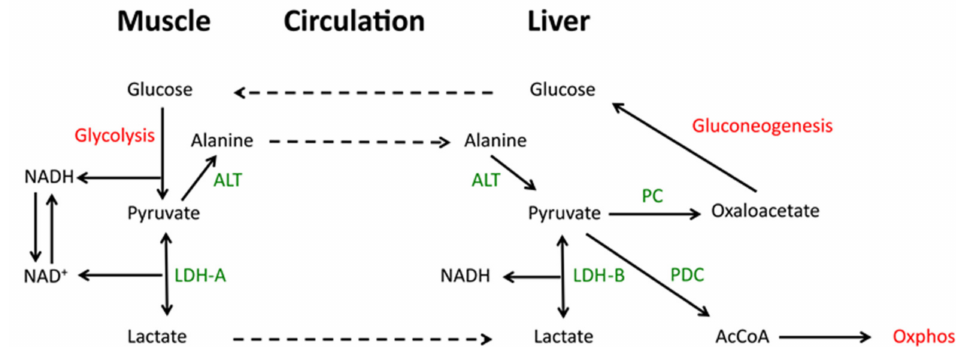
Figure 2. The central role of pyruvate in the Cori and alanine cycles. The Cori cycle: in muscle, anaerobic glycolysis favors lactate production and generates NAD + , which provides the necessary electron acceptor to support further glycolysis. Excreted lactate is converted to pyruvate in the liver via reversal of the LDH reaction. Pyruvate supports Oxphos following its conversion to acetyl-CoA by the PDC or gluconeogenesis following its PC-mediated conversion to oxaloacetate. Released glucose sustains plasma levels, which serve as an exogenous energy source. The alanine cycle: In muscle, alanine is derived from pyruvate via ALT or directly from the breakdown of proteins in response to fasting or tissue damage. The excreted alanine is then reconverted to pyruvate in the liver. Broken arrows: products released/excreted from